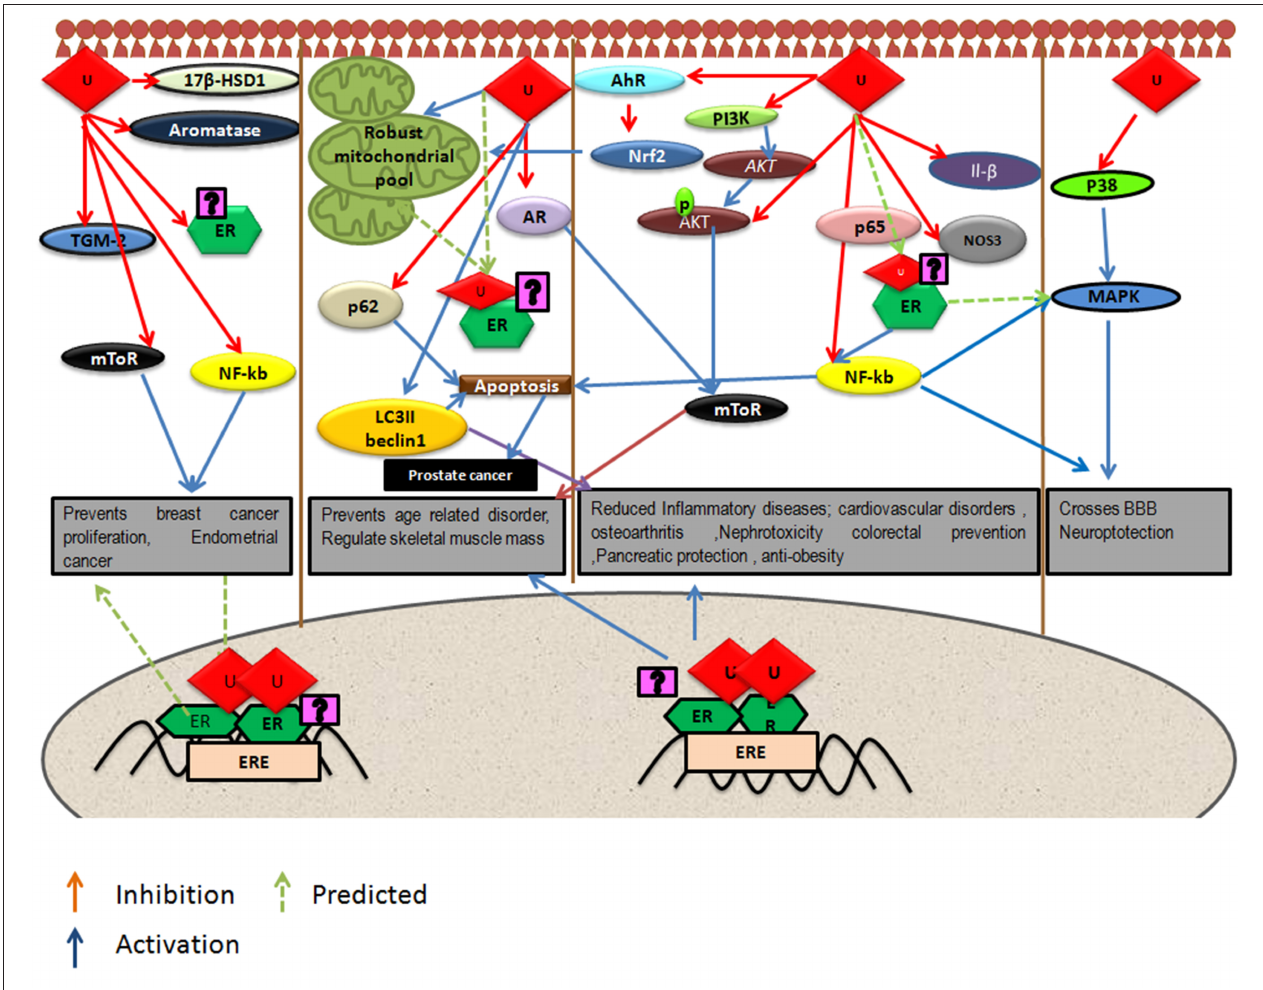
FIGURE 2 | Depicts pathways by which urolithins, mainly Urolithin A and Urolithin B, can act in different tissues were U represents either UA or UB. Some of these beneficial effects might be mediated by Estrogen Receptor α (ER α ) since these pathways have known to be modulated by Estrogen